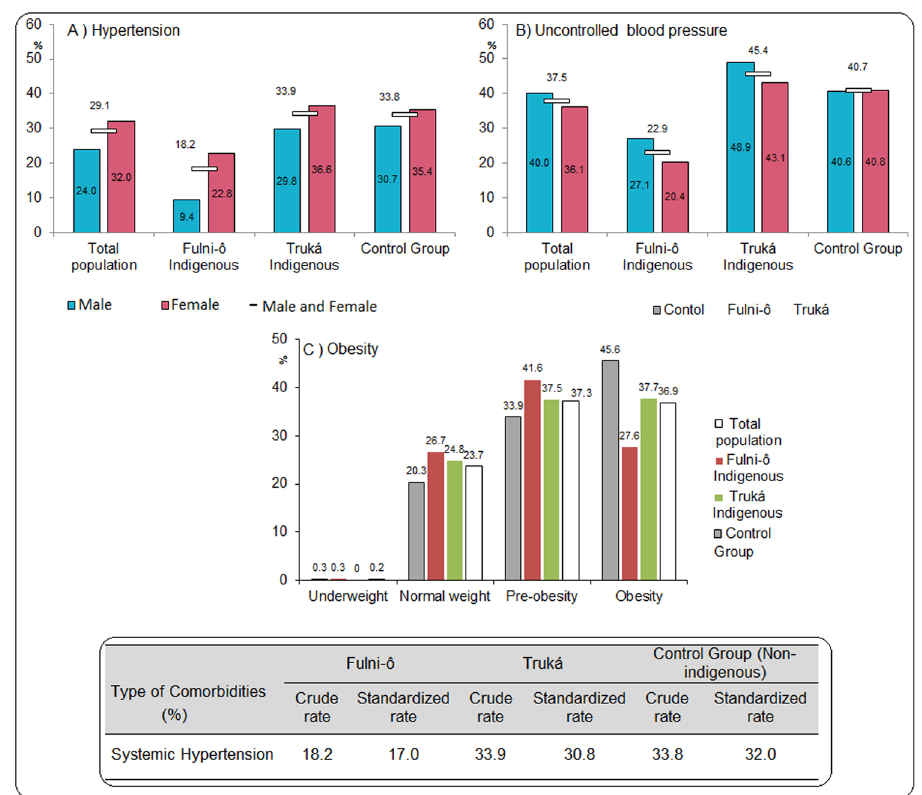
Fig. 2 Prevalence of hypertension and obesity diseases for Fulni-ô Indigenous people, Truká Indigenous people, and urban non-Indigenous population. Brazil. a Hypertension; b Uncontrolled blood pressure; c obesity. Total population ( n = 999): the least urbanized Fulni-ô People ( n = 303; 30.3%); the intermediate urbanized Truká Indigenous group ( n = 336; 33.7%); as well as a highly urbanized cohort living in the city of Juazeiro ( n = 360; 36.0%). *Control group refers to the urban non-Indigenous